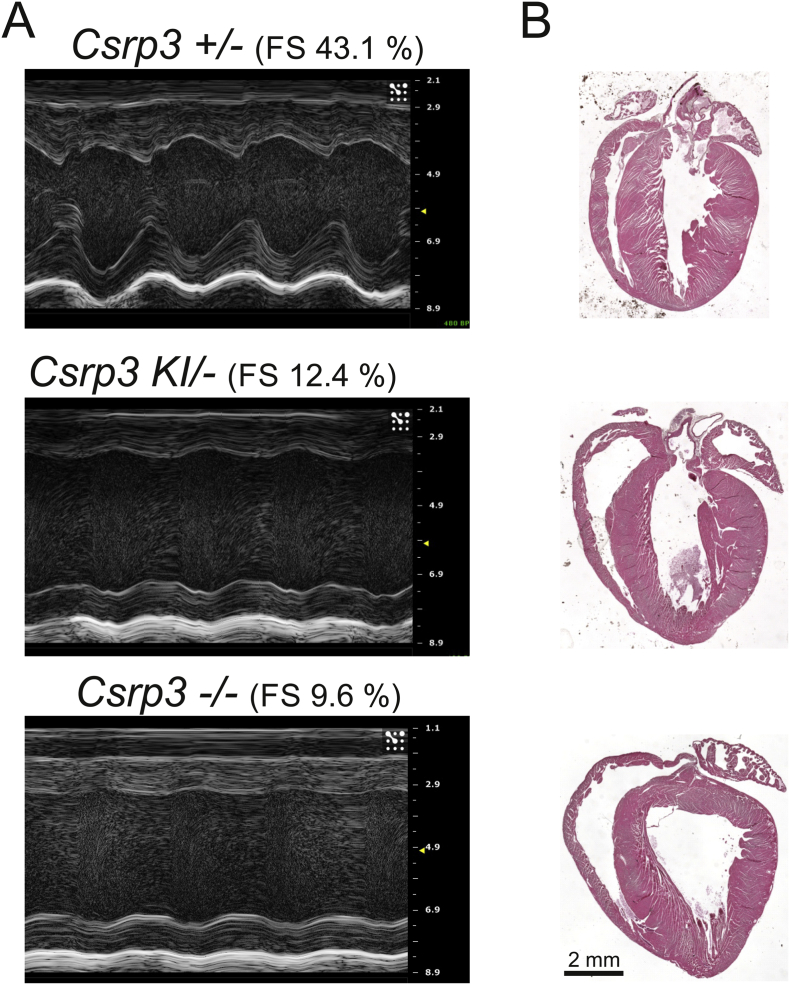
The Csrp3 C58G allele cannot rescue the phenotype of Csrp3-/- knock out mice. A – Representative examples of M-mode echocardiography of Csrp3+/- mice with normal systolic function (top), Csrp3 KI/- mice (middle) and Csrp3-/- mice (bottom), the latter both with impaired systolic function. The calculated value of LV fractional shortening (FS) is given for each mouse. B – Cardiac morphology of the genotypes. Haematoxylin-eosin stained paraffin heart sections are shown.